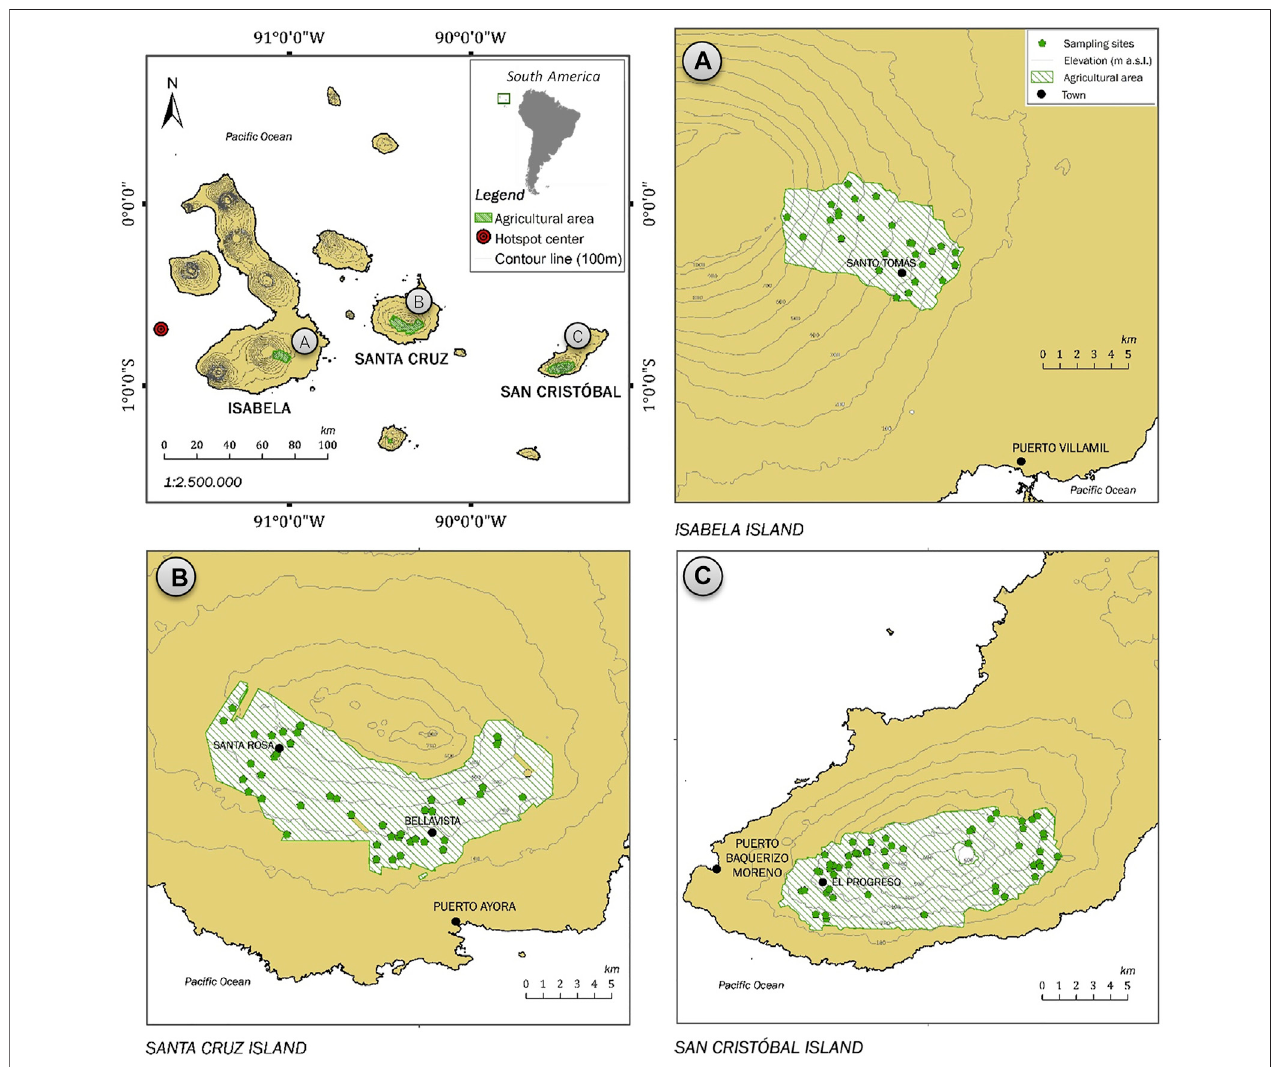
FIGURE1| MapofthesamplinglocationswithintheagriculturalareasofthethreestudiedislandsIsabela,SantaCruzandSanCristóbal.Thecenterofthevolcanic hotspot was estimated by Hooft et al. (2003); m a.s.l. (cid:1) meters above sea level.